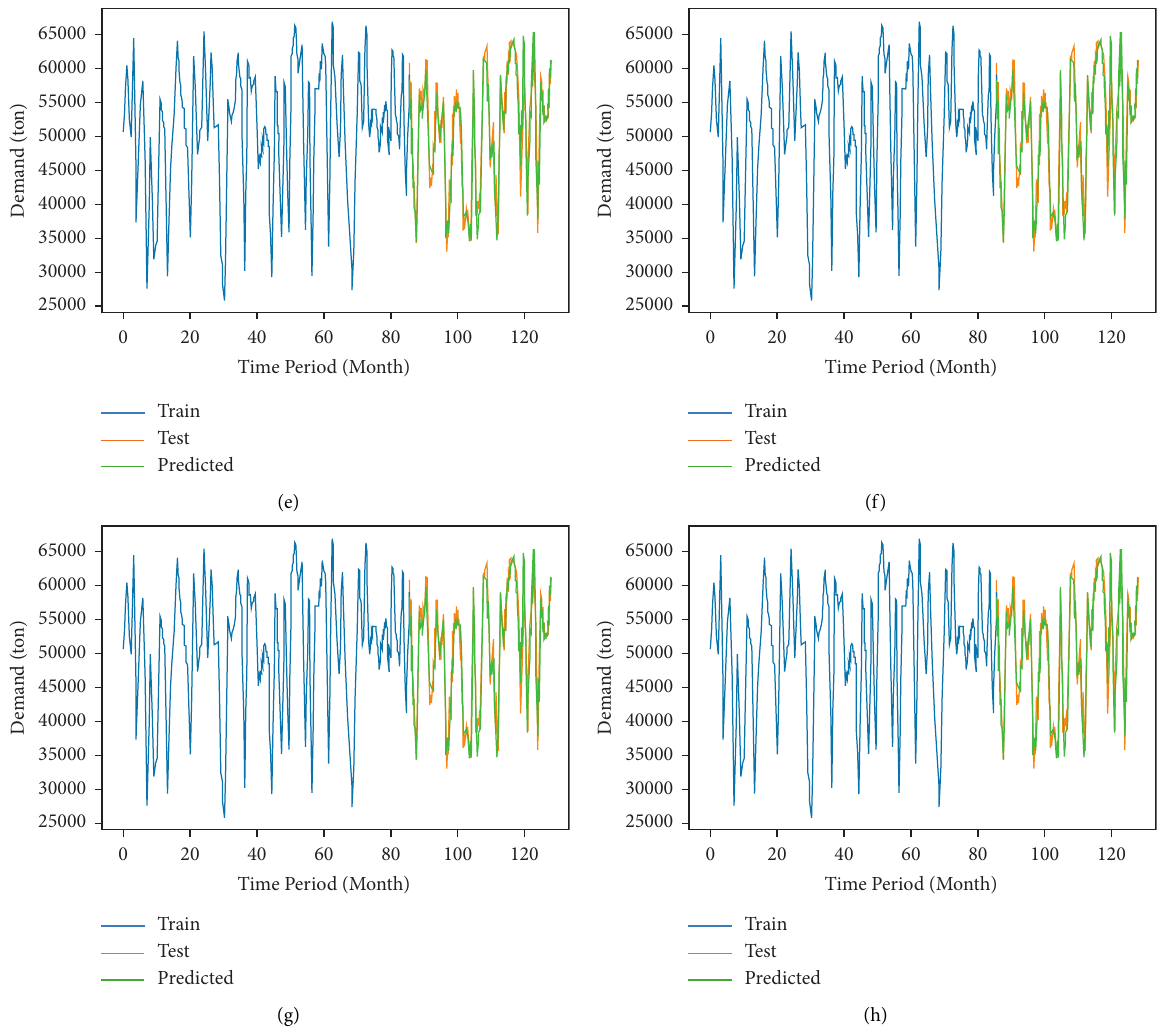
Figure 6: Graphical representation of actual vs predicted demand obtained by (a) SVR, (b) ELM, (c) MLP, (d) RFR, (e) GBR, (f) XGBR, (g) STACK 2 , and (h) STACK 1 models,